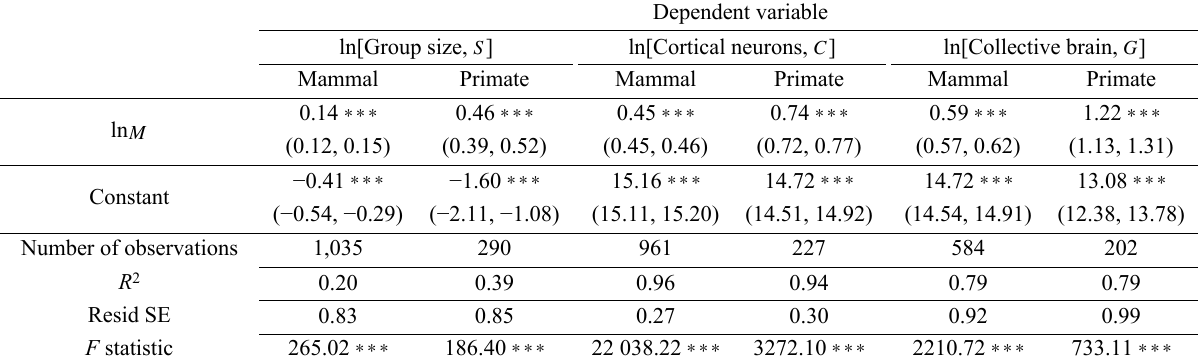
Table 3 Group size, estimated number of cortical neurons, and estimated collective brain